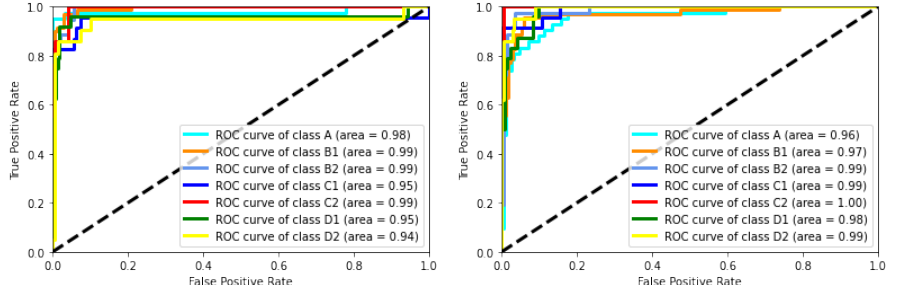
Figure 6. Left panel: The ROC curve for the GDT classifier is shown. The area under the curve for all of the labels is higher than 0.90. Right panel: The ROC curve for the SVM classifier is shown. The area under the curve for all of the labels is higher than 0.95. The classes are consistent with the definition of labels presented in Section 3.1.